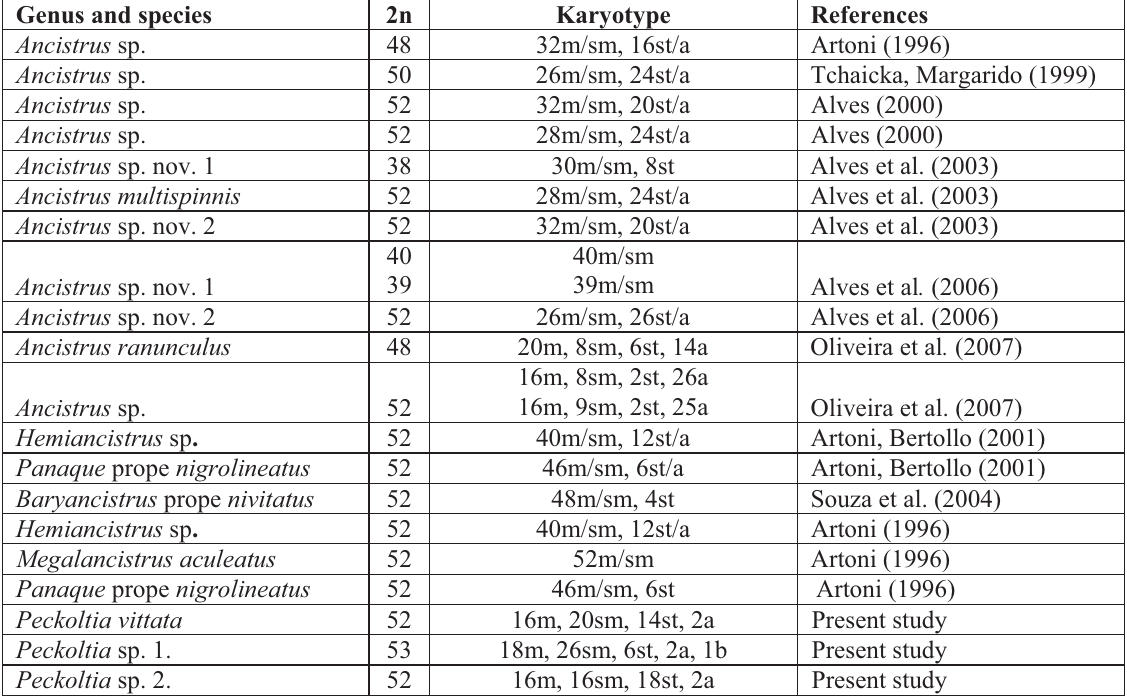
Table 1. Cytogenetic data on fi sh of the tribe Ancistrini (2n - diploid number of chromosomes, M – metacen- tric, SM – submetacentric, ST – subtelocentric, A – acrocentric, B - supernumerary